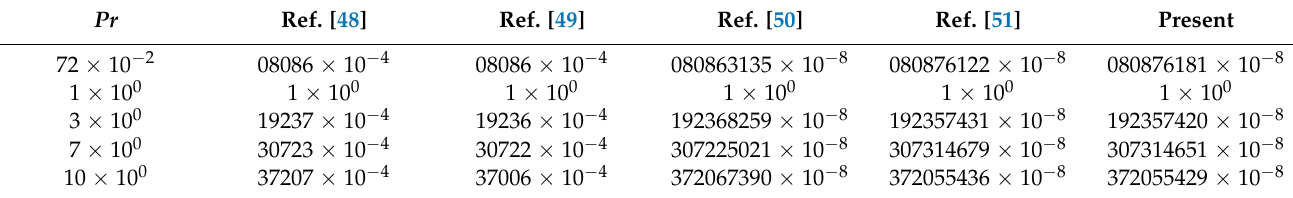
Table 3. Comparison of − θ (cid:48) ( 0 ) with various values of Pr when φ = 0, (cid:101) = 0, Λ = 0, Nr = 0, S = 0, and B ς = 0. Pr Ref. [48] Ref.